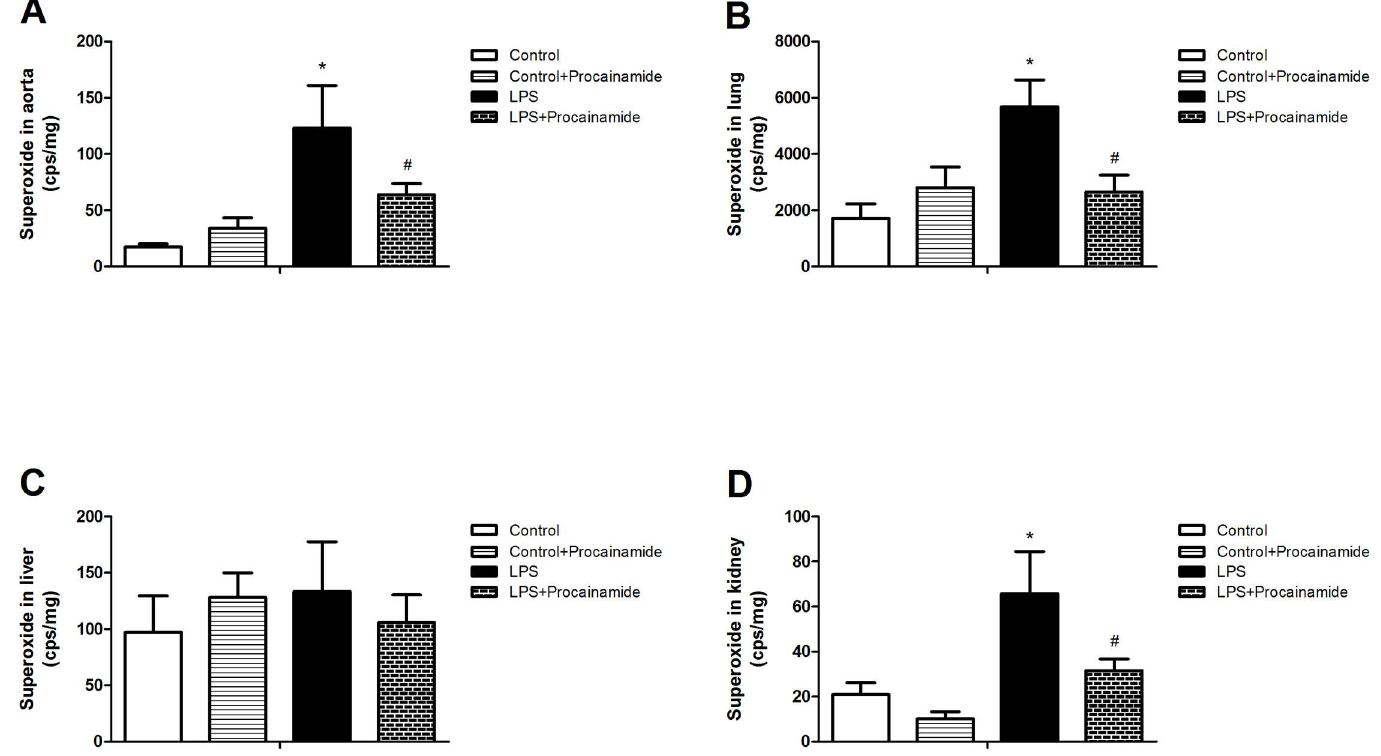
Fig 4. Effects of procainamide on superoxide levels in (A) aortas, (B) lungs, (C) livers, and (D) kidneys obtained from endotoxemic rats. Depicted are changes at the end of experiments (at 6 h) in different groups of animals that received saline at time 0 (Control, n = 6), received saline as in Control group and then received procainamide at 1 h (Control + Procainamide, n = 6), received LPS at time 0 (LPS, n = 6), and received LPS at time 0 and then received procainamide at 1 h (LPS + Procainamide, n = 6). Data are expressedas mean ± SEM. * P < 0.05, all versus Control rats; # P < 0.05, with versus without procainamide in LPS